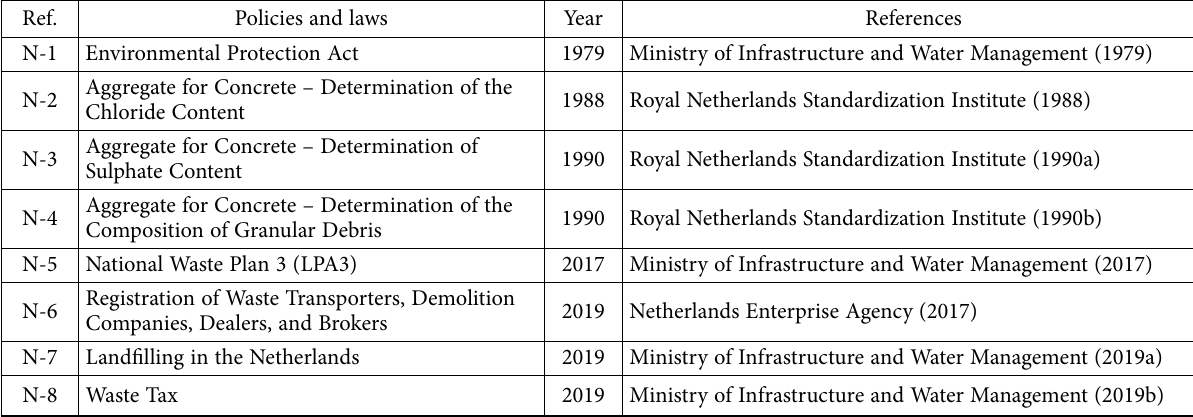
Table 6. Existing policies and laws on C&D waste management in the Netherlands